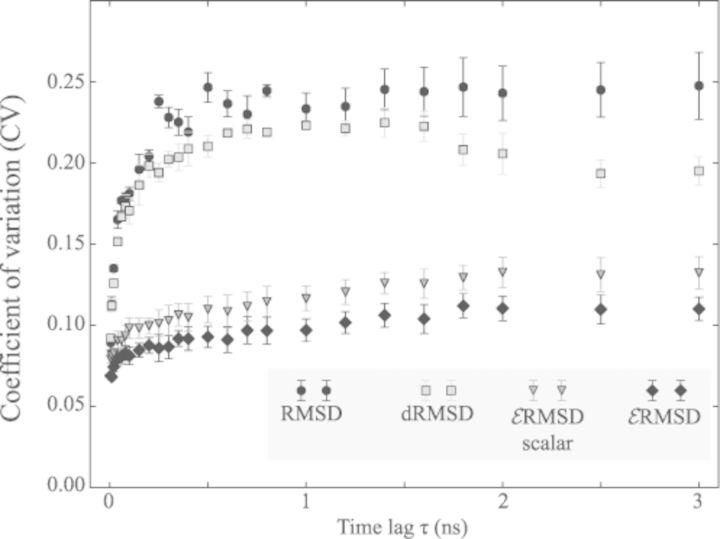
Coefficient of variation calculated on a 100 ns molecular dynamics simulation of the add riboswitch. The coefficient of variation for the \documentclass[12pt]{minimal}
\usepackage{amsmath}
\usepackage{wasysym}
\usepackage{amsfonts}
\usepackage{amssymb}
\usepackage{amsbsy}
\usepackage{upgreek}
\usepackage{mathrsfs}
\setlength{\oddsidemargin}{-69pt}
\begin{document}
}{}$\mathcal {E}$\end{document}RMSD is compared with heavy-atoms RMSD, with the distance RMSD (dRMSD) and with the scalar variant of the \documentclass[12pt]{minimal}
\usepackage{amsmath}
\usepackage{wasysym}
\usepackage{amsfonts}
\usepackage{amssymb}
\usepackage{amsbsy}
\usepackage{upgreek}
\usepackage{mathrsfs}
\setlength{\oddsidemargin}{-69pt}
\begin{document}
}{}$\mathcal {E}$\end{document}RMSD. Standard deviations are calculated using a blocking procedure.